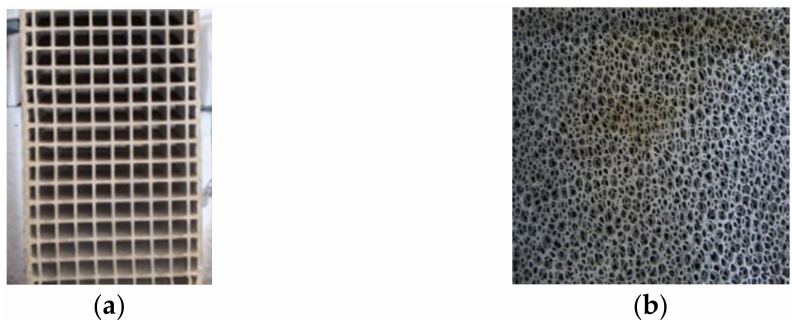
Figure 15. Honeycomb catalyst with ceramic carrier ( a ) [47] and catalytic foamed ceramic ( b ) [25]. (a) Reprint with permission from G. Reichert, Primary- and Secondary Measures for Manually